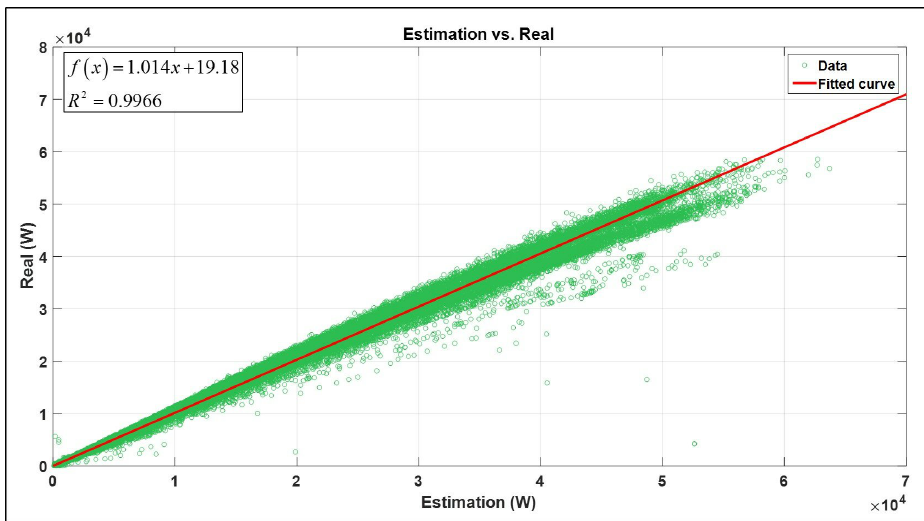
Figure 18. The estimated vs. real photovoltaic power of